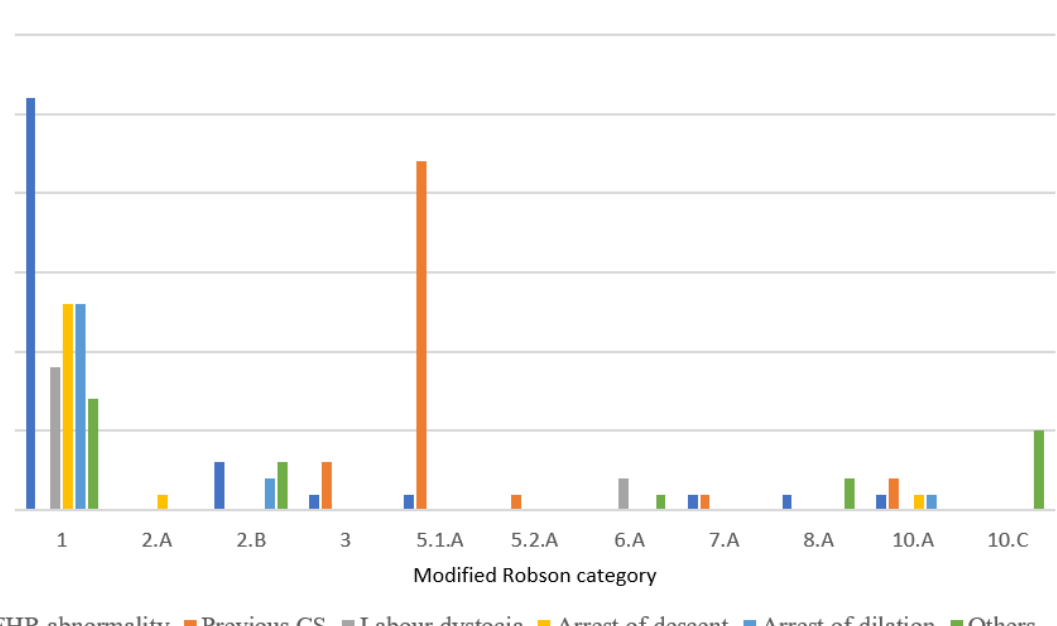
Table 3. Statistical description of newborn outcomes in modified Robson groups.